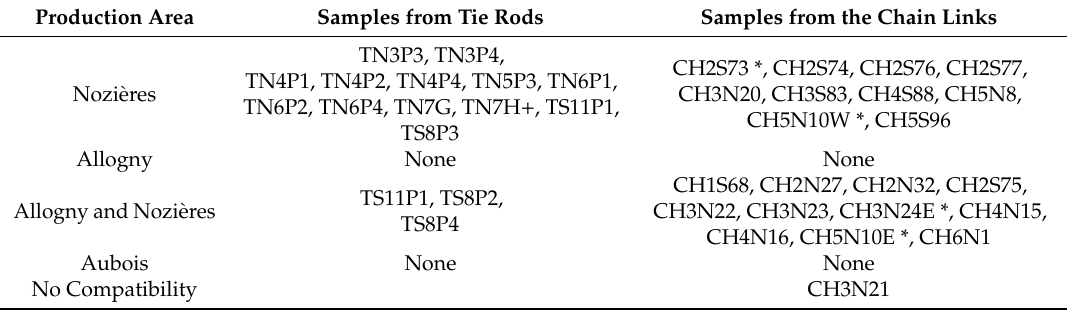
Table 5. Results of the PCA analyses comparing one single artefact with a single production area, (* indicates recycled samples characterized by metallographic and elemental analyses).